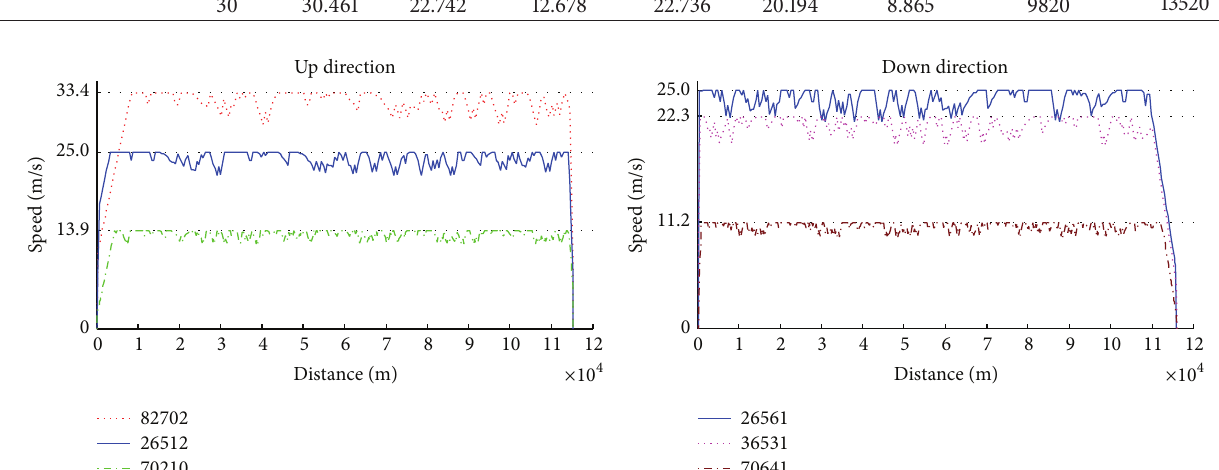
Figure 6: Train speed-distance curve (section 3 is 30000 m, without NCBS).